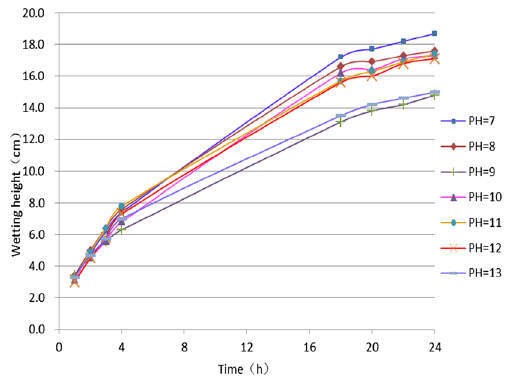
Fig. 3 Pulverized coal’s average wetting height varying with the change of time in the solutions with different pH values